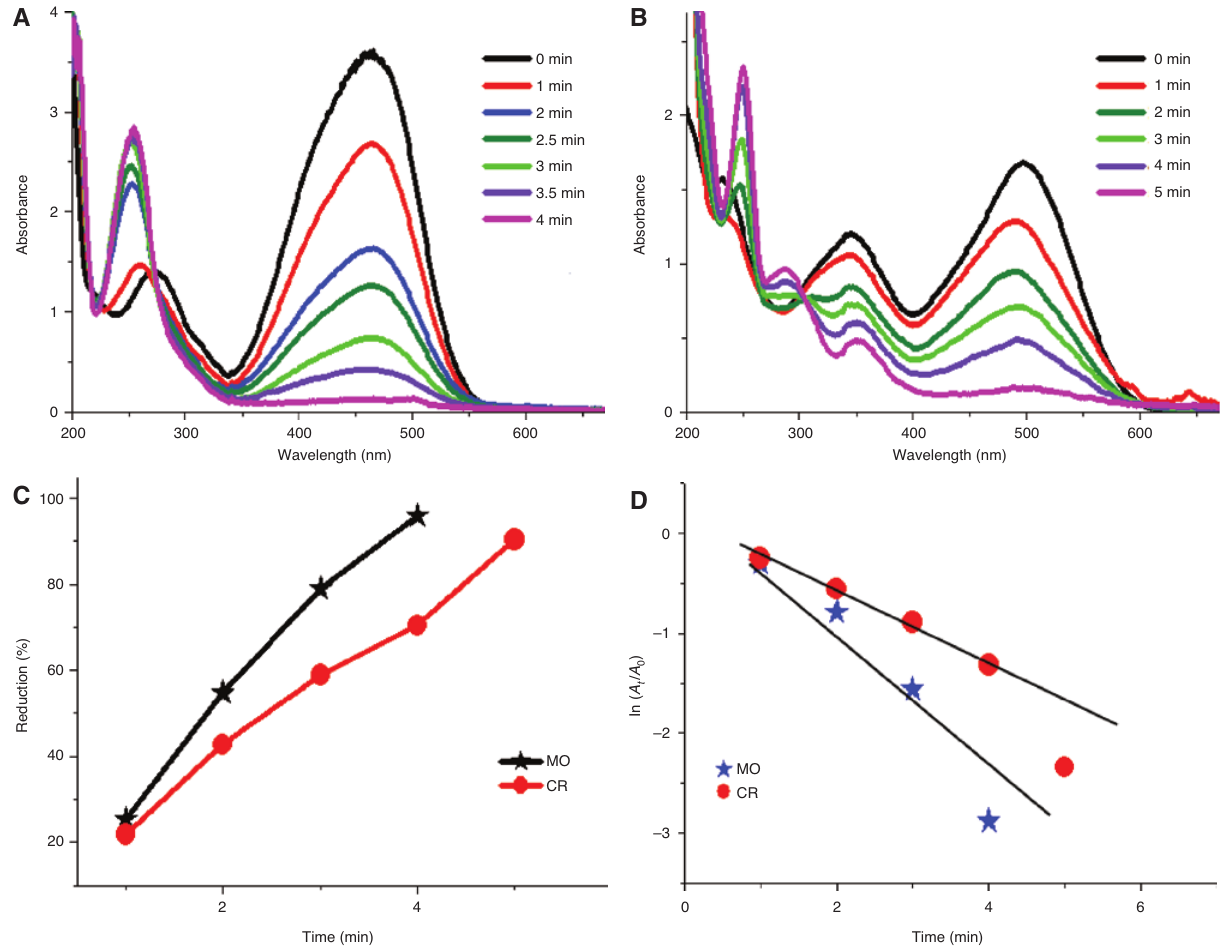
and CuNPs, (B) CR reduction by NaBH Figure 7: UV-visible spectra of (A) MO reduction by NaBH 4 of MO and CR, and (D) plot of ln ( A / A ) versus time for MO and CR. Experimental conditions (3 ml of aqueous dye solution + 0.5 ml of 0.2 m t 0 aqueous NaBH solution + 5 mg of 4